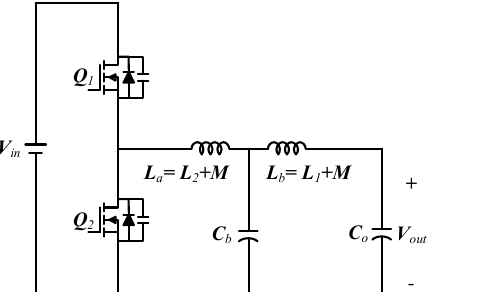
Figure 5. LL-LC circuit: ( a ) transformer type; ( b ) T-type equivalent form.